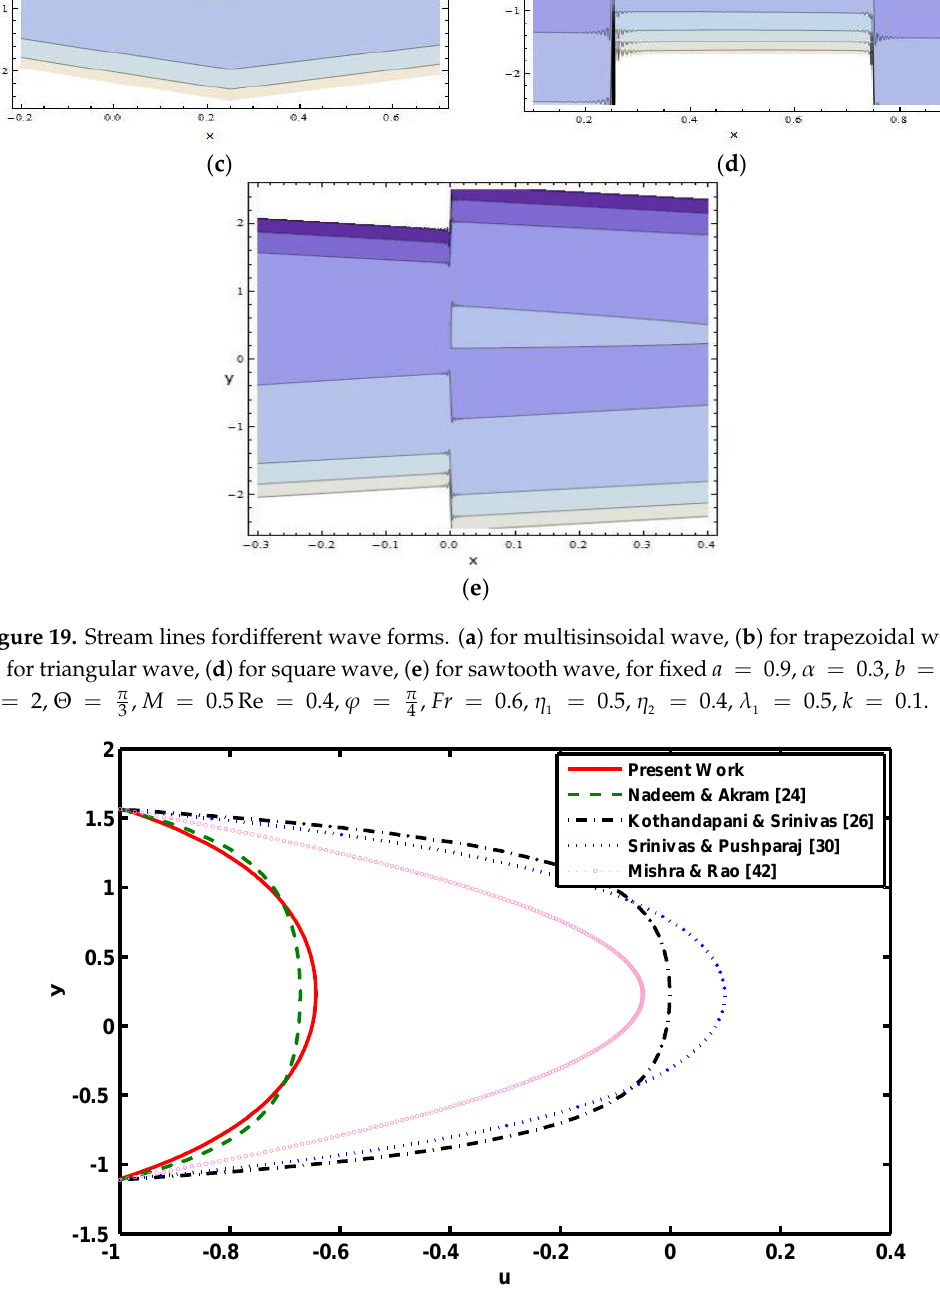
Figure 20. Comparison of the present work with existing literature.